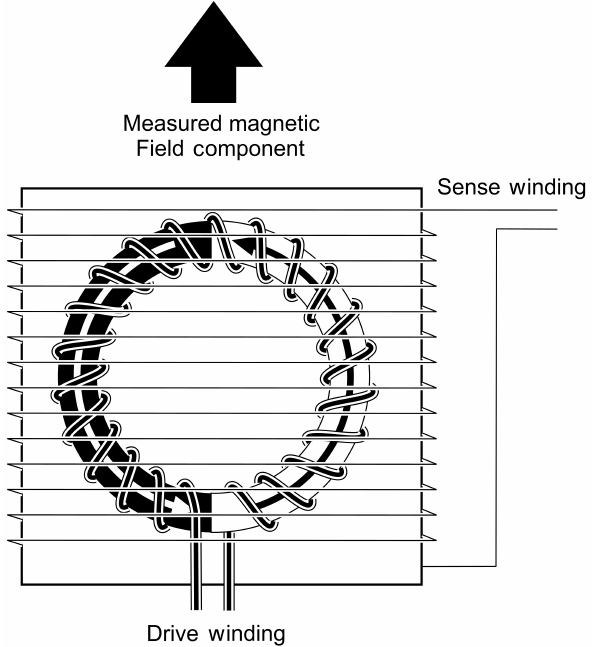
Figure 1. Schematic illustration of a single sensor axis of a ring- core fluxgate